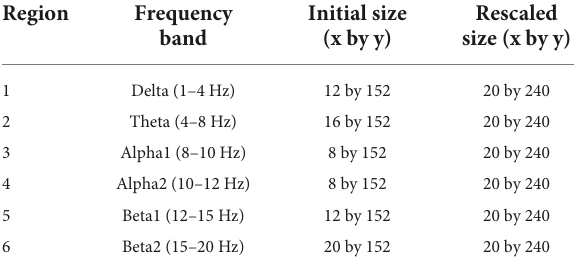
TABLE 1 Size of each frequency band region before and after the rescaling